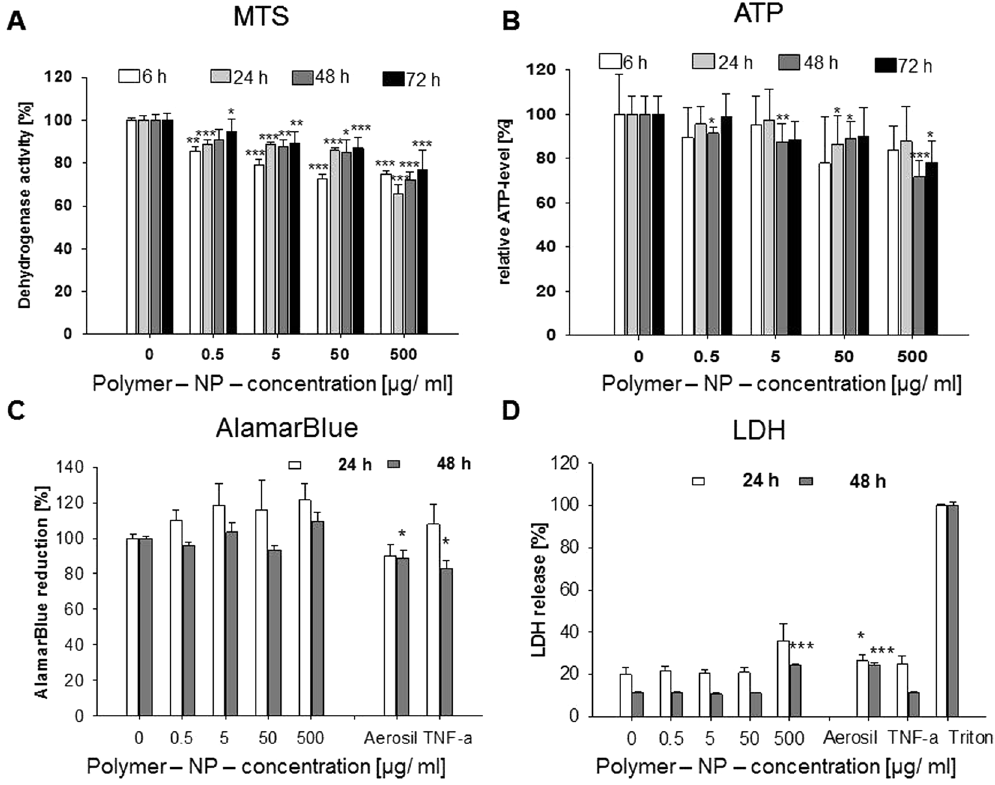
Figure 4. Vitality of HepG2 cells after incubation with polymer-NPs as determined by different laboratories and read-outs. HepG2 were incubated with increasing concentrations of the polymer-NPs for different incubation times (up to 72 h). ( A ) Effect of polymer-NP on metabolic dehydrogenase activity as detected via MTS-assay. ( B ) Relative cellular ATP-levels were detected by ATPLite assay. ( C ) Cellular dehydrogenase activities measured via AlamarBlue assay. ( D ) LDH release after nanoparticle exposure. In ( C , D ) 250 µ g/mL Aerosil 200-NPs und 20 ng/mL TNF- α were additionally used as controls. All data were normalized to control values (no particle exposure or Triton X-100), which were set as 100%. ( A , B ) N = 1 with 6 parallels; ( C , D ) N = 3 with 2 parallels, means and standard deviation ( * p < 0.05; ** p < 0.01, *** < 0,001 in comparison to untreated controls).